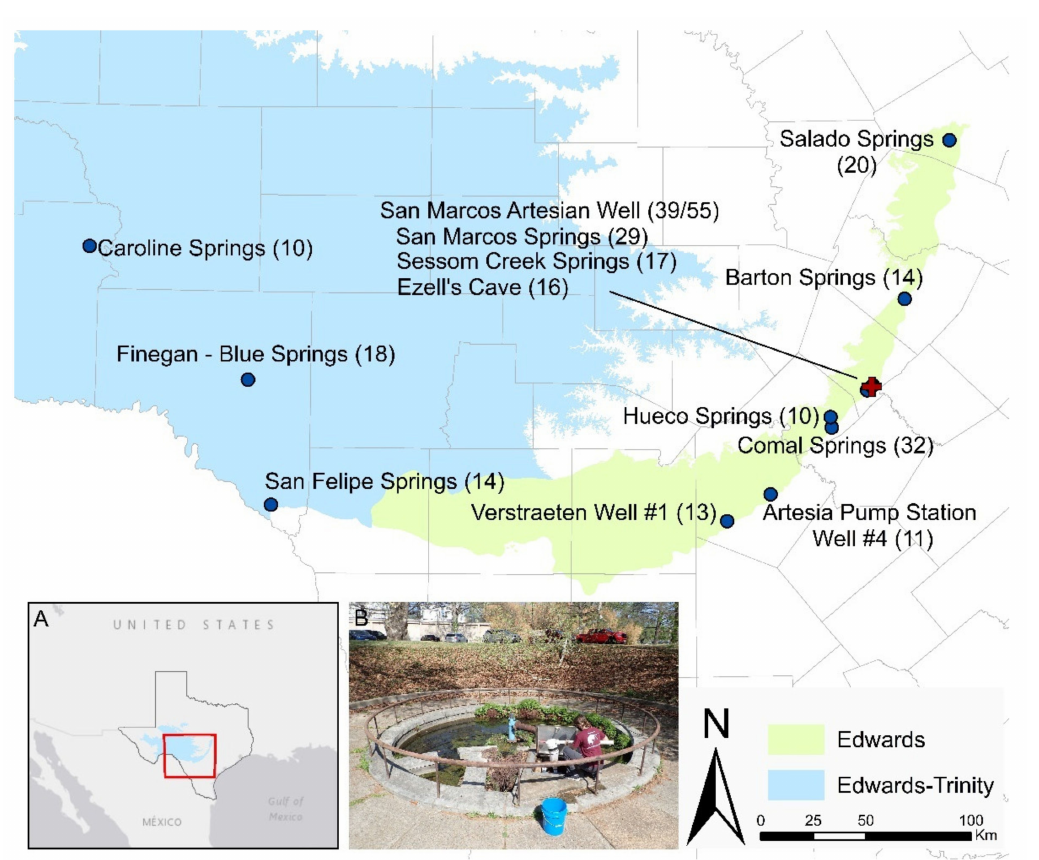
Figure 1. San Marcos Artesian Well and other diverse groundwater sites (>10 stygobionts) in the Edwards and Edwards- Trinity Aquifers. Species richness in parentheses. Inset A: Overview map. Inset B: San Marcos Artesian Well. Two numbers reported for the SMAW are published records (39) used in β -diversity analyses and published + unpublished, undetermined taxa